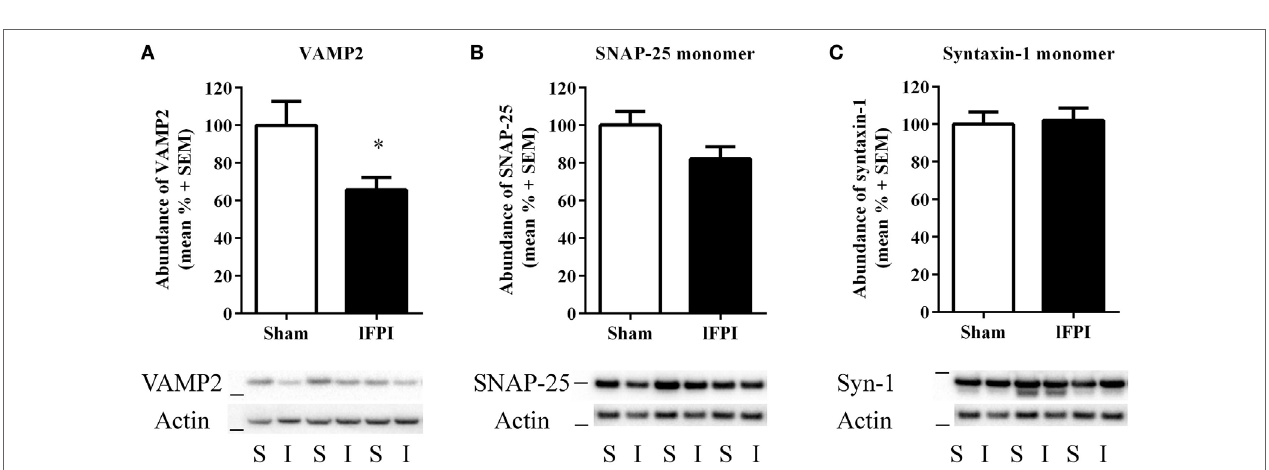
FigUre 4 | Lateral fluid percussion injury (lFPI) reduced VAMP2 abundance in the hippocampus. (a) Representative western blot image of VAMP2 in hippocampal synaptosomal lysates at 1 week post-injury ( n = 3 per group shown). Assessment of VAMP2 (18 kDa, marker is 14 kDa) in lFPI-injured rats (I) revealed significantly reduced abundance compared with sham (S) rats (* p < 0.01). (B) Representative western blot image of synaptosomal-associated protein of 25 kDa (SNAP-25) monomer (25 kDa, marker is 28 kDa) in lFPI-injured rats revealed a modest reduction compared with sham rats, but it did not reach significance. (c) Representative western blot image of syntaxin-1 monomer (35 kDa, marker is 38 kDa) in lFPI-injured rats revealed no change in abundance compared with sham rats. Proteins were normalized to actin (42 kDa, marker is 38 kDa) ( n = 6 sham and n = 6 lFPI).